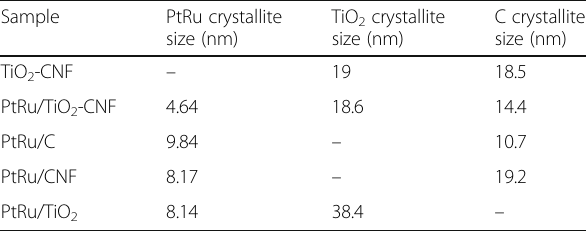
Table 2 PtRu, TiO 2 , and C crystallite sizes for all